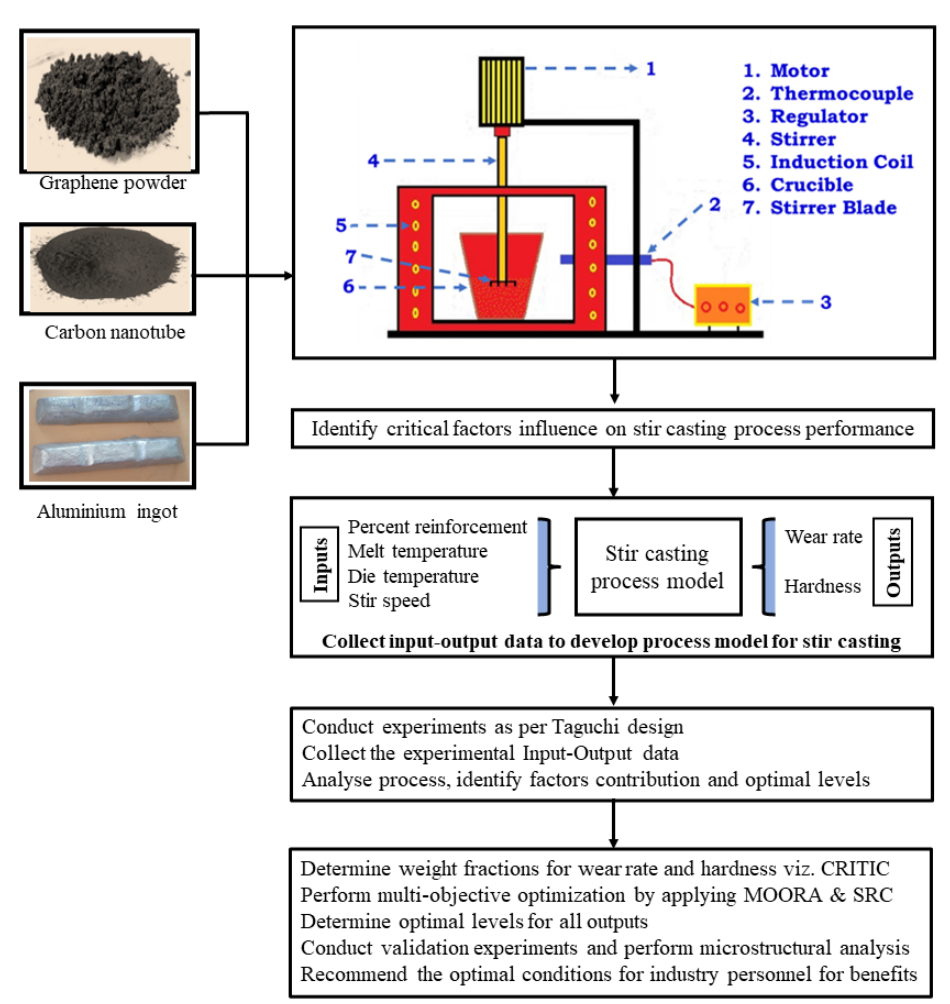
Figure 3. Schematic representation and framework of stir cast process modeling and optimization. Response Measurements and